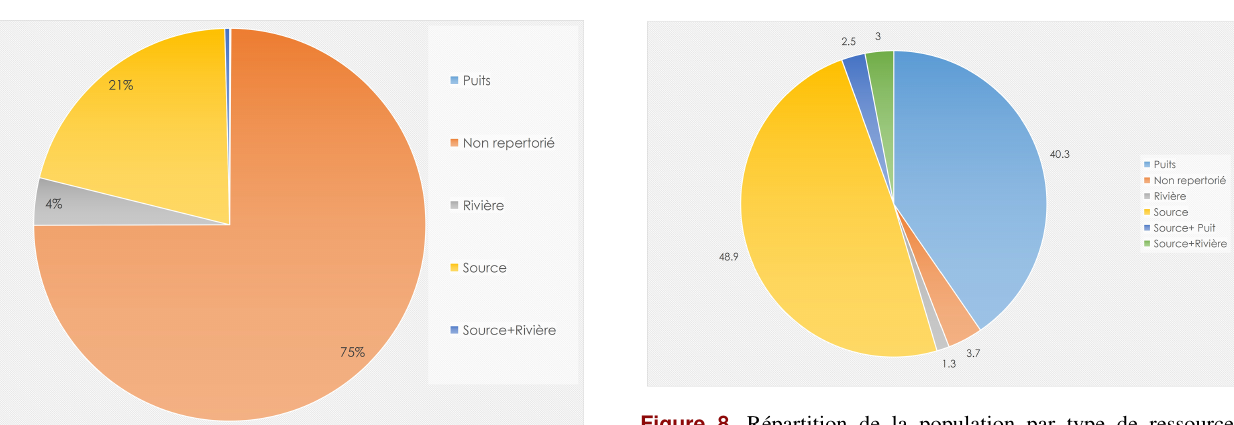
Figure 8. Répartition de la population par type de ressources dans la Commune Urbaine Rurale d’Ambositra (Direction de l’Eau Amoron’i Mania, données non